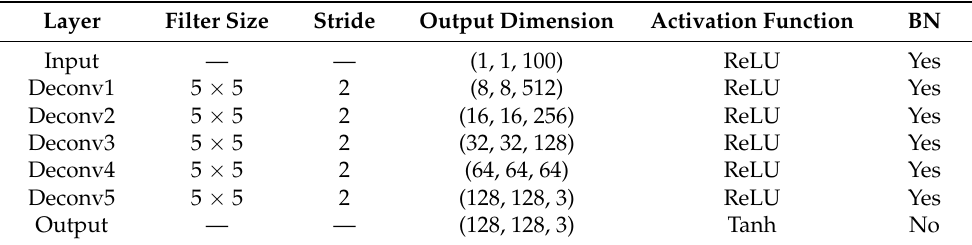
Table 4. The detailed information of the generative model.